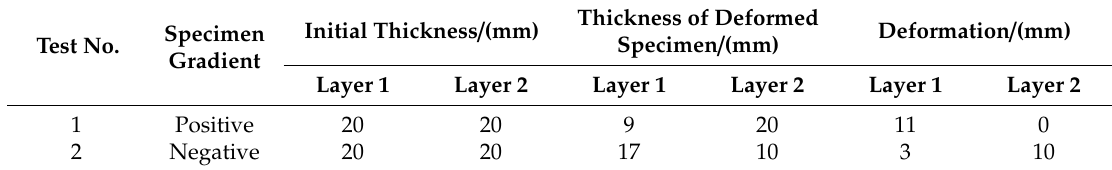
Figure 4. Cross-sections of deformed specimens.